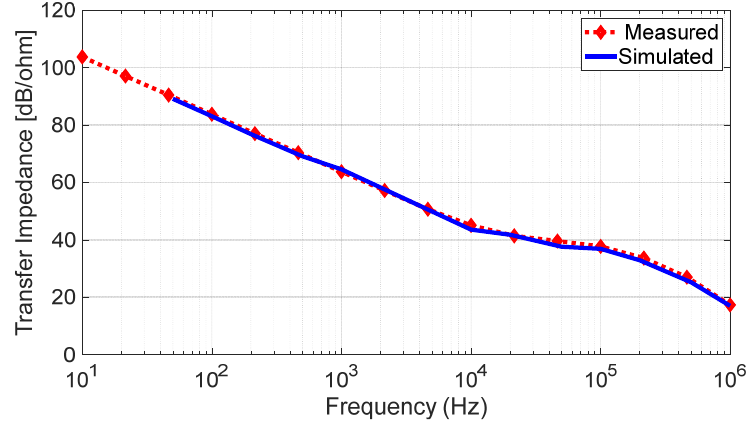
Figure 8. Measured and simulated responses of the loop filter.